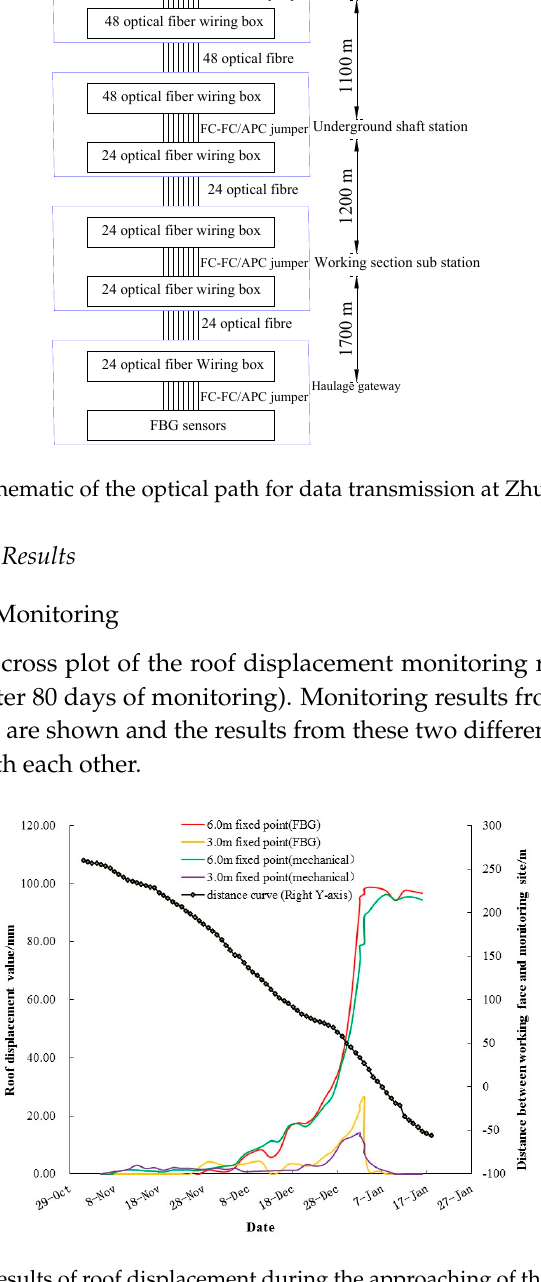
Figure 17. Monitoring results of roof displacement during the approaching of the 1111(1) longwall face.